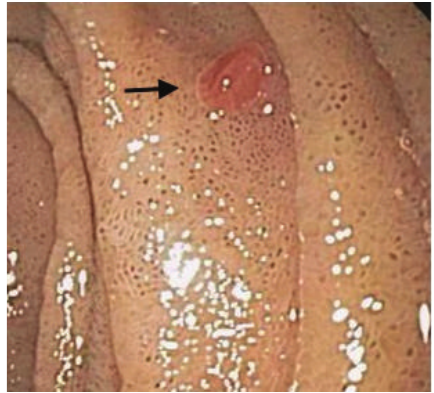
Figure 2: Upper gastrointestinal endoscopy revealing a nodule (arrow) in the second part of the duodenum.